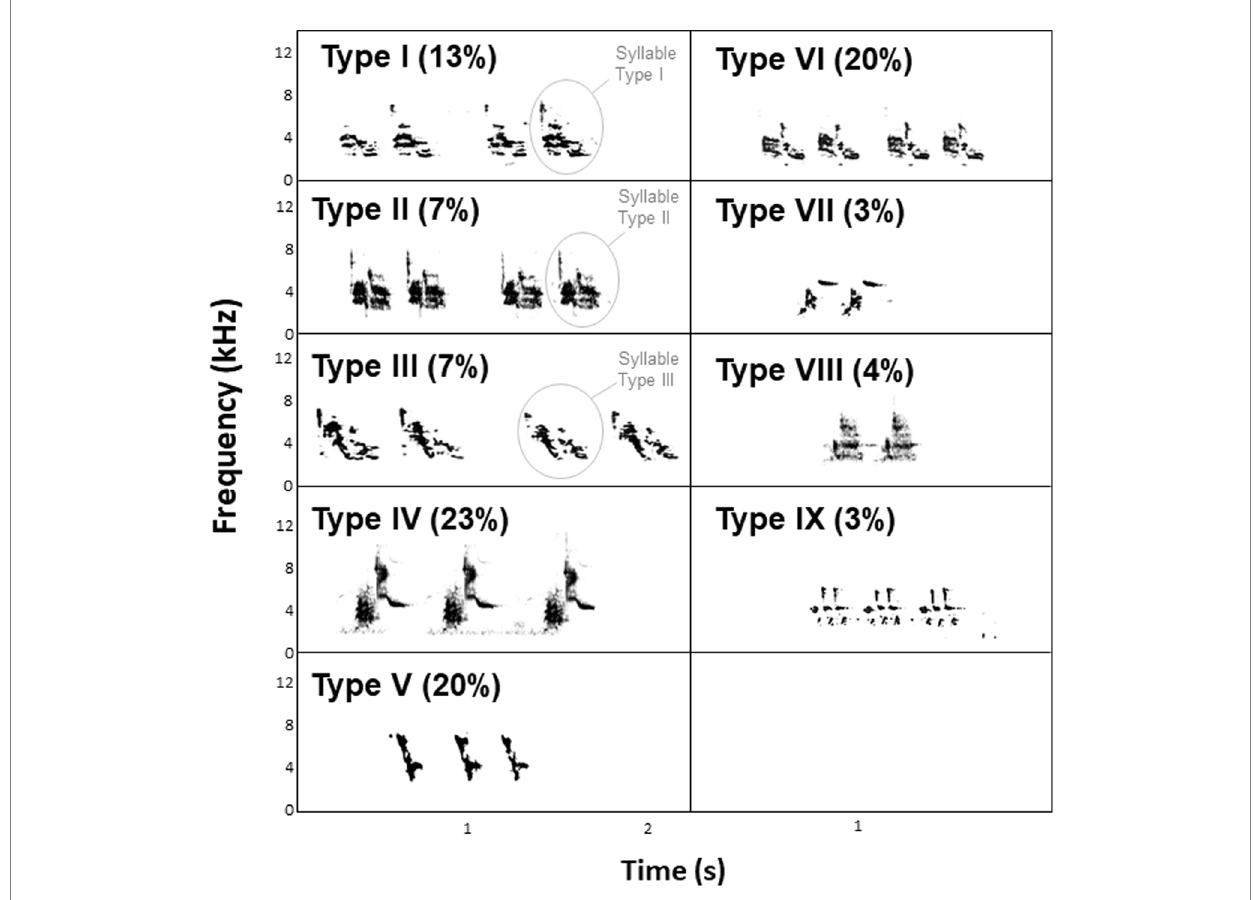
FIGURE 2 Spectrograms and percentages of the different syllable types recorded in small ground finches on Floreana Island in